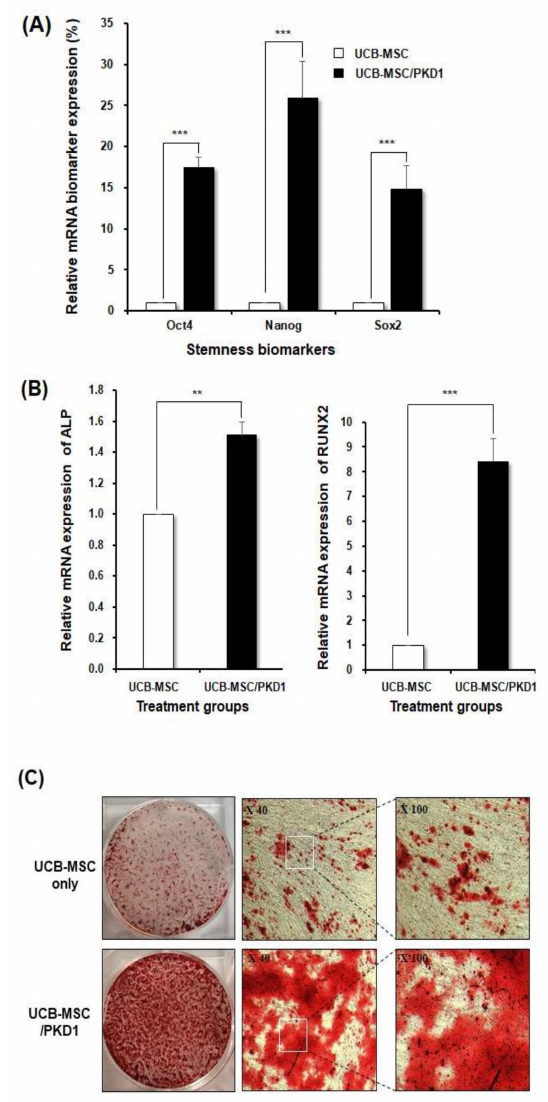
Figure 5. The expression of the increased stemness biomarkers and improved osteogenic differ- entiation ability of PKD1 -expressing UCB-MSC. To evaluate the potential of stem cells by PKD1 transfection, the expression of stemness markers Oct4, Nanog, and Sox2 was detected by RT-PCR, and the differentiation ability of UCB-MSC was examined by alizarine red S staining to confirm the induction level of osteogenic differentiation: ( A ) The expression level of stemness biomarkers and ( B ) the expression level of osteogenic differentiation biomarkers induced by PKD1 in UCB-MSC; ( C ) The degree of the differentiation into osteocyte in PKD1 -expressing UCB-MSC via alizarin red S staining. Data shown represent the mean ± SD ( n = 3). ** p < 0.02, *** p < 0.01, for UCB-MSC only group versus UCB-MSC/ PKD1